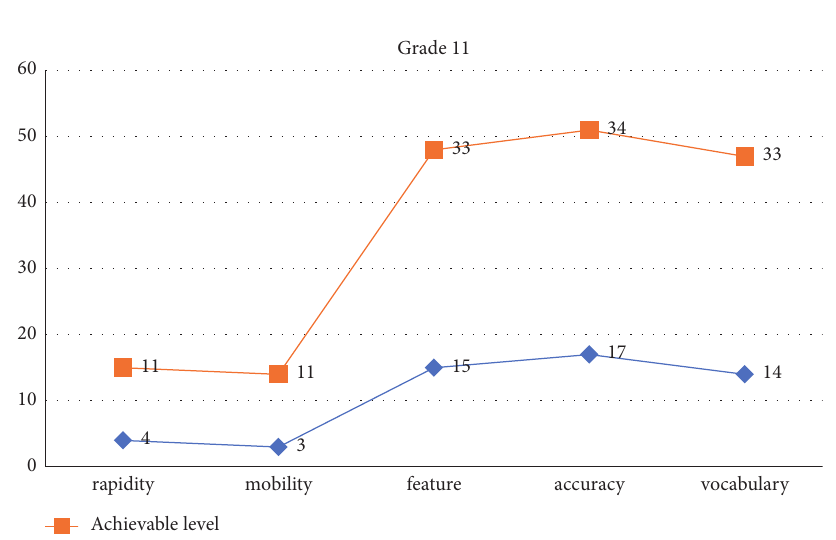
Figure 7: Achieved level of student creativity.